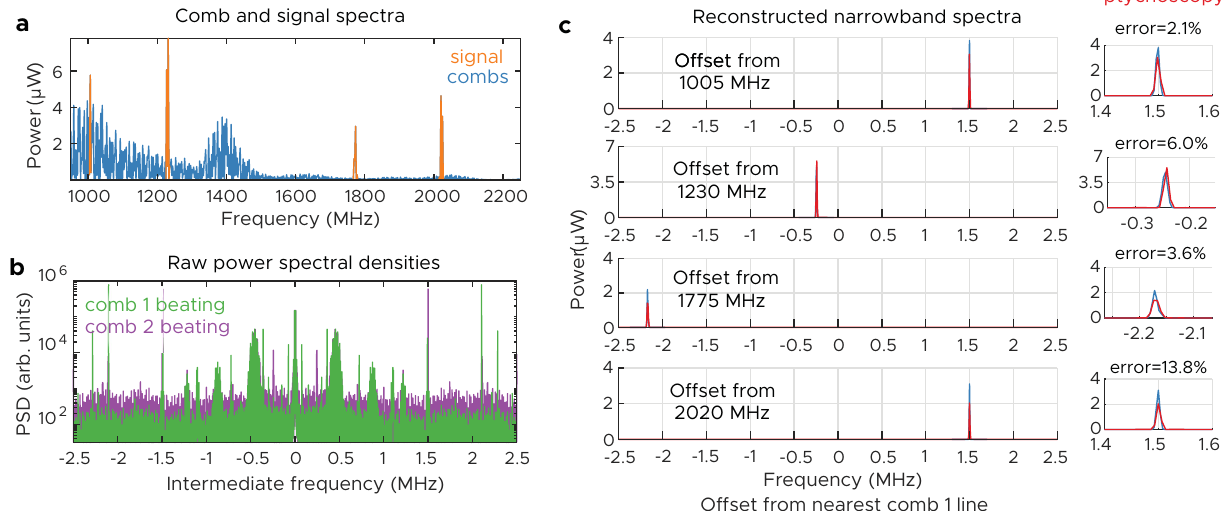
Fig. 5 Narrowband microwave ptychoscopic experiment. Ptychoscopic reconstruction of narrowband signals that span an octave. a Spectrum of the signal that is to be measured, along with the spectrum of combs ’ lines. b Raw power spectral density recorded on the two detectors, showing a complex mix of spectra. c Ptychoscopic reconstruction of data and of real signals, along with the error of the integrated power. Note that the two methods have different instrument lineshapes and resolution bandwidths — this results in different peak heights, but the integrated powers are similar (see